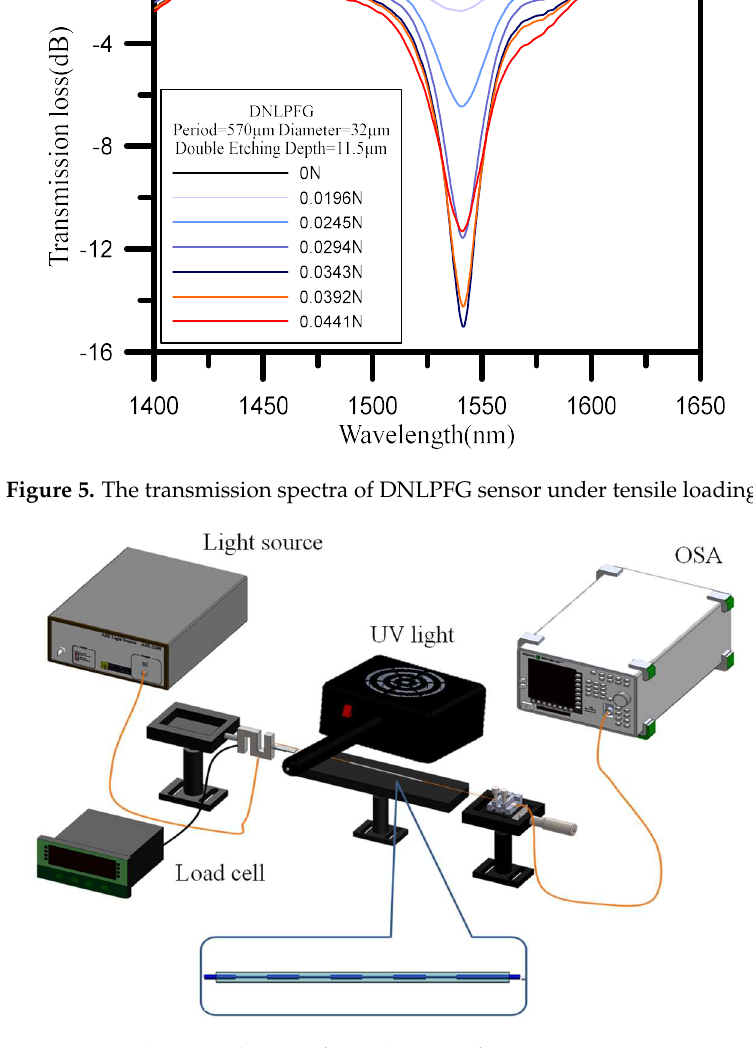
Figure 6 . Schematic diagram for packaging of DNLPFG CO 2 gas sensor.